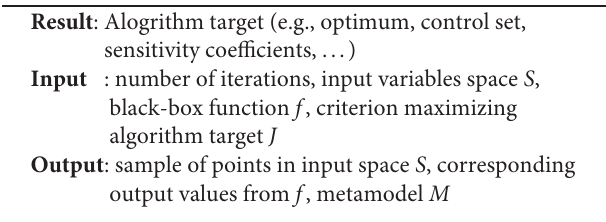
Algorithm 2: Batch sequential design of numerical experiments procedure based on J criterion of